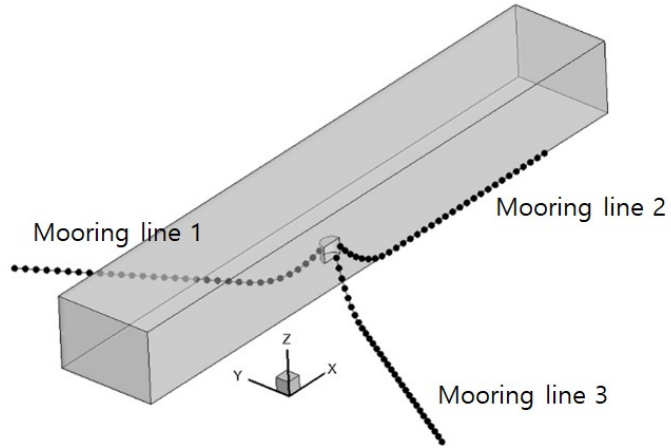
Figure 11. Calculational nodes of mooring lines.